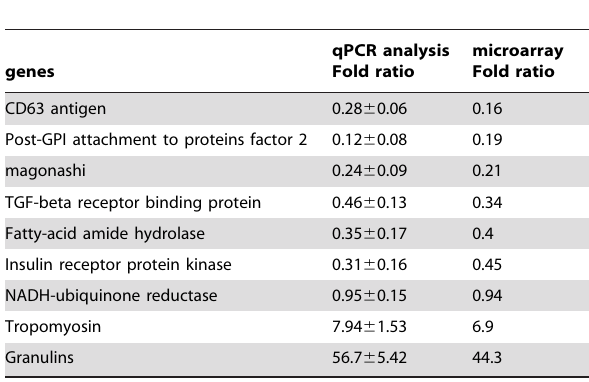
Table 3. Results of real-time qPCR confirmation of gene microarray data.